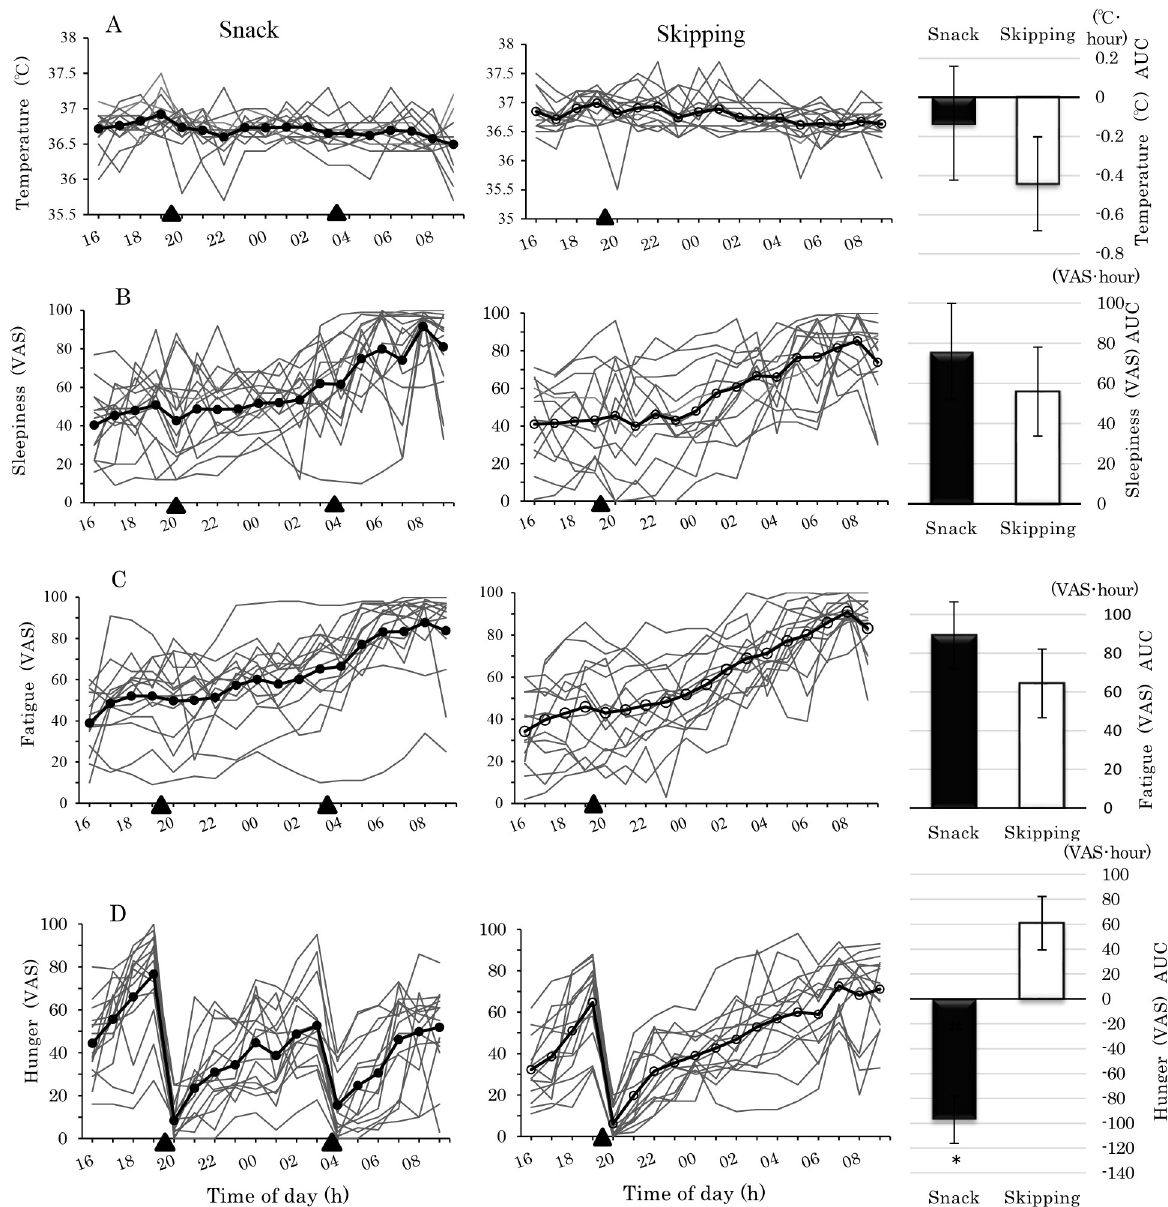
Fig 3. Temperature, sleepiness, fatigue, and hunger following a simulated night shift. A-Temperature, B-Sleepiness (VAS: Visual Analog Scale), C-Fatigue (VAS), D-Hunger (VAS). Left side and center panels display the individual data per condition from 16:00 to 09:00 testing points. Snack condition—left side panel, Skipping condition—center panel. The means are shown over the top of the individual data. Both conditions are thick solid black lines, the Snack condition is shown with a black circle, and the Skipping condition is shown with an open circle. Black triangle ( ▲ ) indicates eating a meal at 19:30 and at 03:30. The average values of the markers in the left side and center panels match columns in the right side panels for each condition, before and after eating, from 03:00 to 09:00. Bars represent standard error. Analysis of covariance was used to assess the significance of mean differences between groups after eating ( � : p <